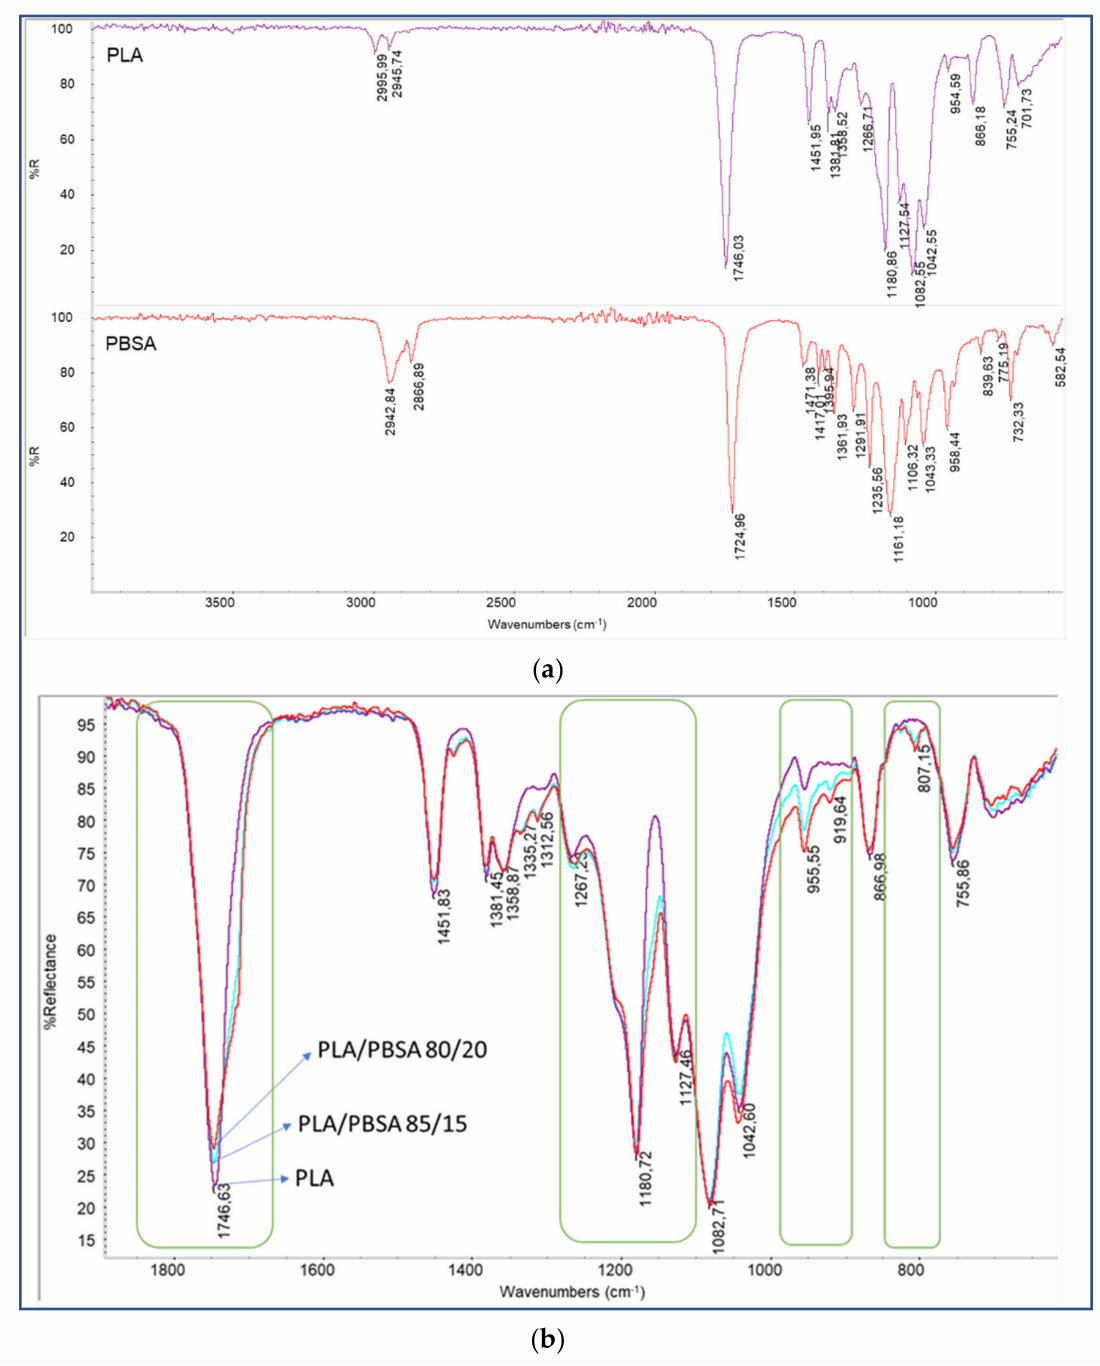
Figure 1. ( a ) ATR spectra of pure PLA and PBSA; ( b ) ATR spectra of PLA-PBSA